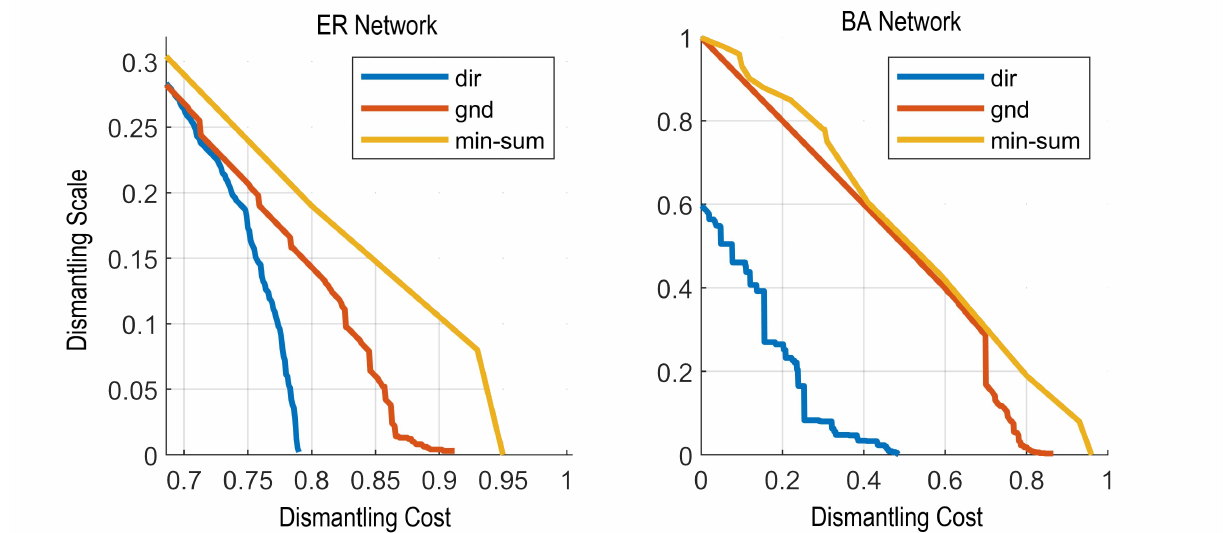
Figure 2. Curve graph of the disassembly cost and disassembly scale of directed ER random network and directed BA random